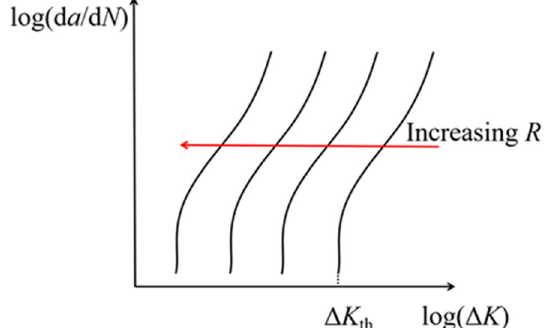
Figure 1 Crack growth rate curves under different R